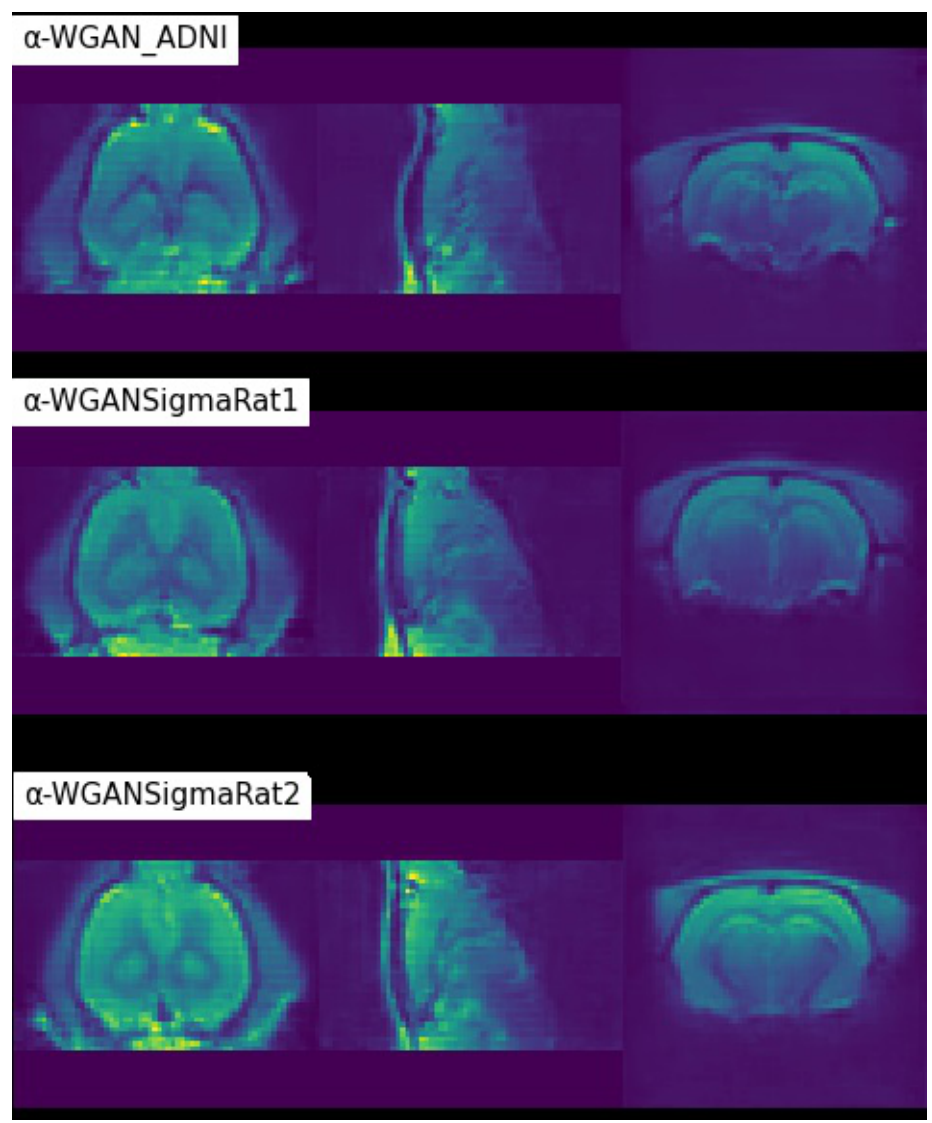
Figure 7. Coloured visualisation of scans generated by different models in the coronal, sagittal and axial planes,